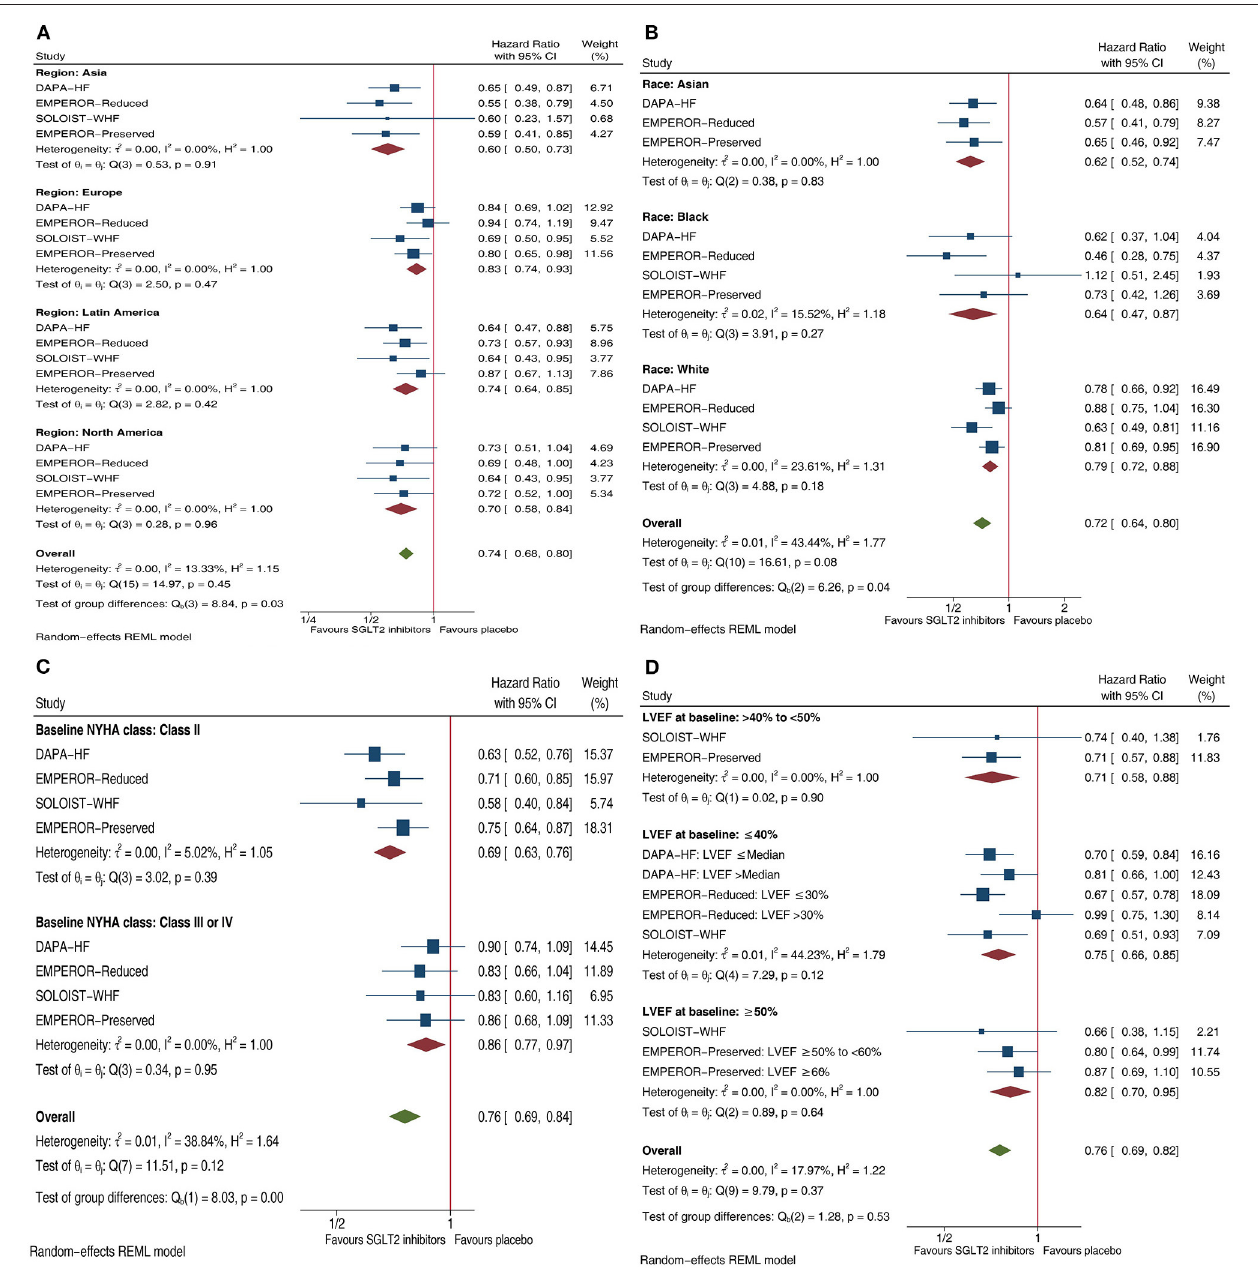
FIGURE 1 | Forest plots illustrating the effect of SGLT2 inhibitors on composite HF outcome in patients with HF by four important factors. (A) Effects of SGLT2 inhibitors on composite HF outcome in HF patients by Regions. (B) Effects of SGLT2 inhibitors on composite HF outcome in HF patients by Race. (C) Effects of SGLT2 inhibitors on composite HF outcome in HF patients by Baseline NYHA class. (D) Effects of SGLT2 inhibitors on composite HF outcome in HF patients by LVEF at baseline. SGLT2, sodium-glucose co-transporter-2; HF, heart failure; CI, confidence interval; NYHA, New York Heart Association; LVEF, left ventricular ejection fraction; Composite HF outcome: defined as a composite of hospitalization for HF or cardiovascular